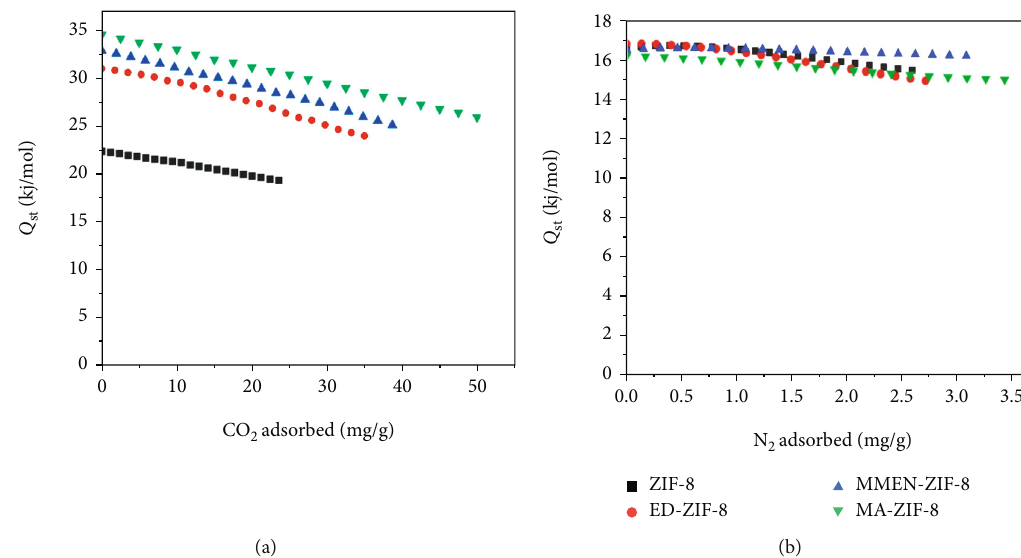
Figure 9: Dependence of isosteric heat of adsorption on the amounts adsorbed of CO . N 2